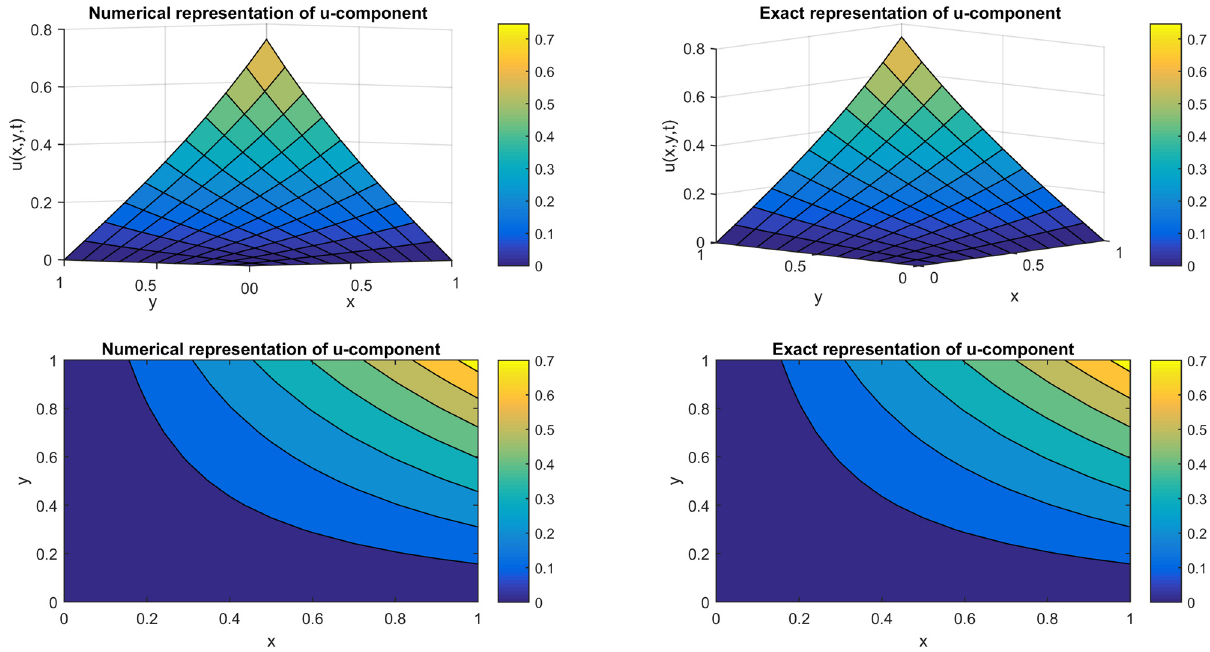
Figure 13: Surface and contour plots for u component at = t 1 for = N 11 , = α 50 , = β 5 , = t Δ 0.0001 , and = τ 0.5 using Method I regarding Example 7.